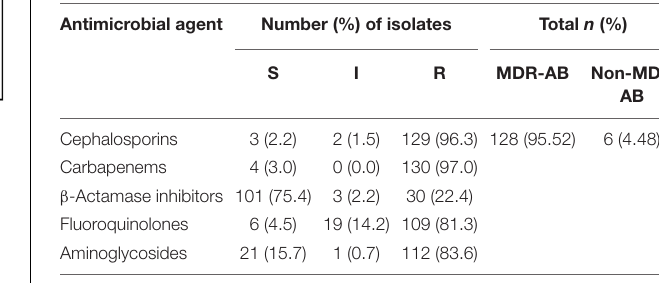
TABLE 3 | Antimicrobial susceptibility of 134 AB isolates.